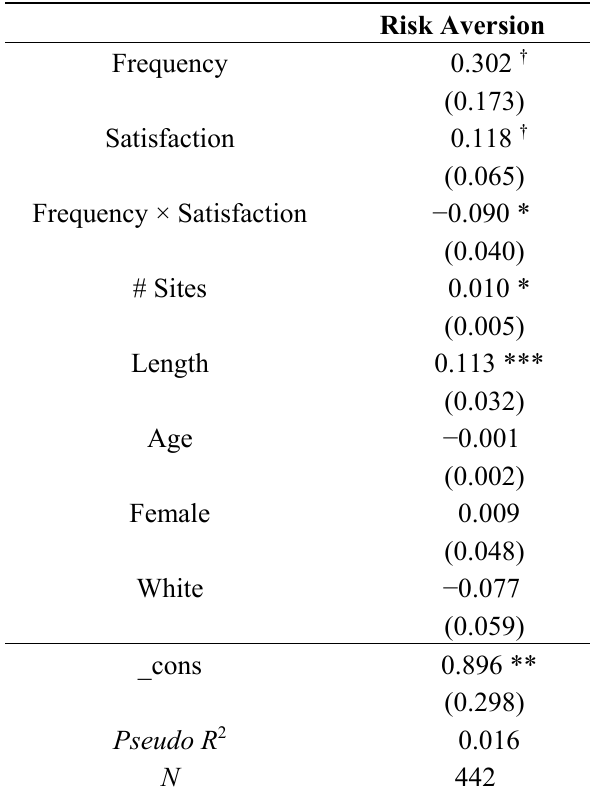
Table 7. Negative binomial regression results predicting risk aversion at wave